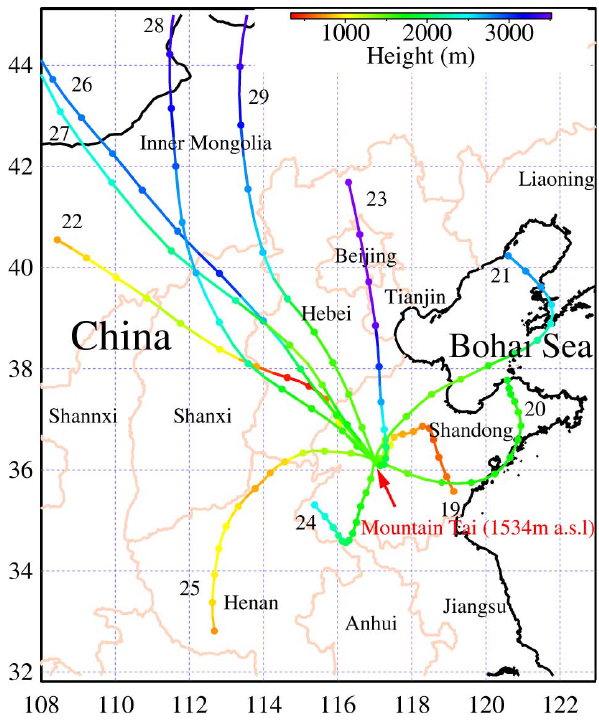
Fig. 3. 24-h air mass back trajectories arriving at 24:00 (lo- cal time) to the summit of Mt. Tai (1540ma.s.l) from 19 to 29 April 2010. Date number is marked on each trajectory, and solid dots on each line represent 2-h intervals (http://ready.arl.noaa.gov/